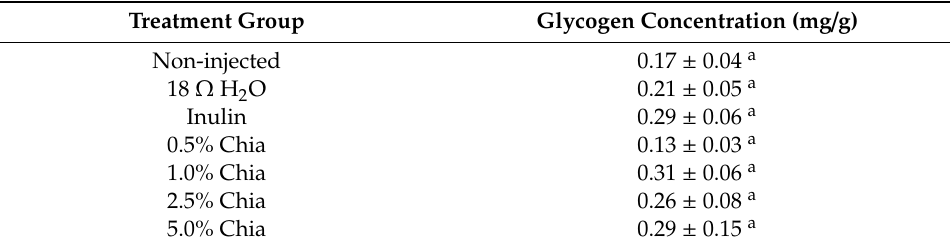
Table 6. Concentration of glycogen in pectoral muscle.